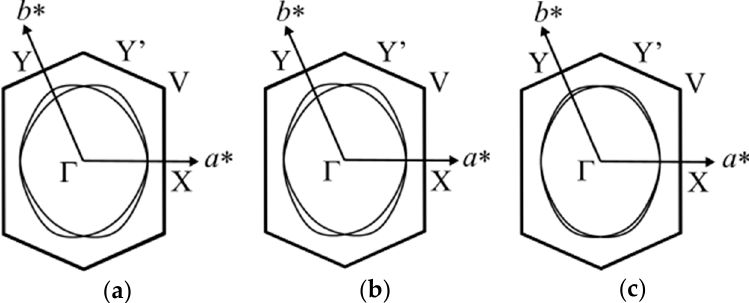
Figure 4. Fermi surface of the EtMe 3 Sb salt calculated by the extended Hückel and tight binding methods at 5 K ( a ), 101 K ( b ), and 295 K ( c ). The C -centered monoclinic cell is reduced to the primitive one as a p = ( a + b )/2, b p = b , c p = c .